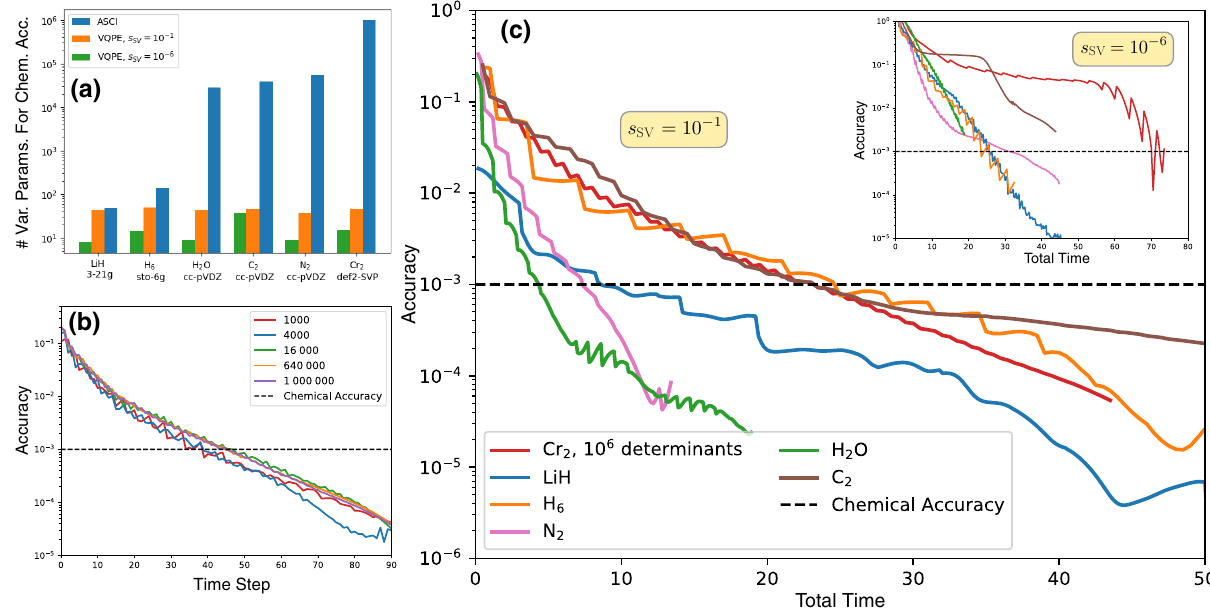
FIG. 10. (a) Number of variational parameters to reach chemical accuracy using ASCI (a classical selected configuration interaction approach), and the VQPE algorithm with different s SV values. These parameters correspond to determinants in ASCI, and to expansion states in VQPE. (b) Comparison of convergence for all different Hilbert space sizes of Cr 2 . (c) Convergence for all the molecules as a function of total time ( s SV = 10 − 1 ) with the inset showing convergence of the first excited state that has nonzero overlap with the reference state ( s SV = 10 − 6